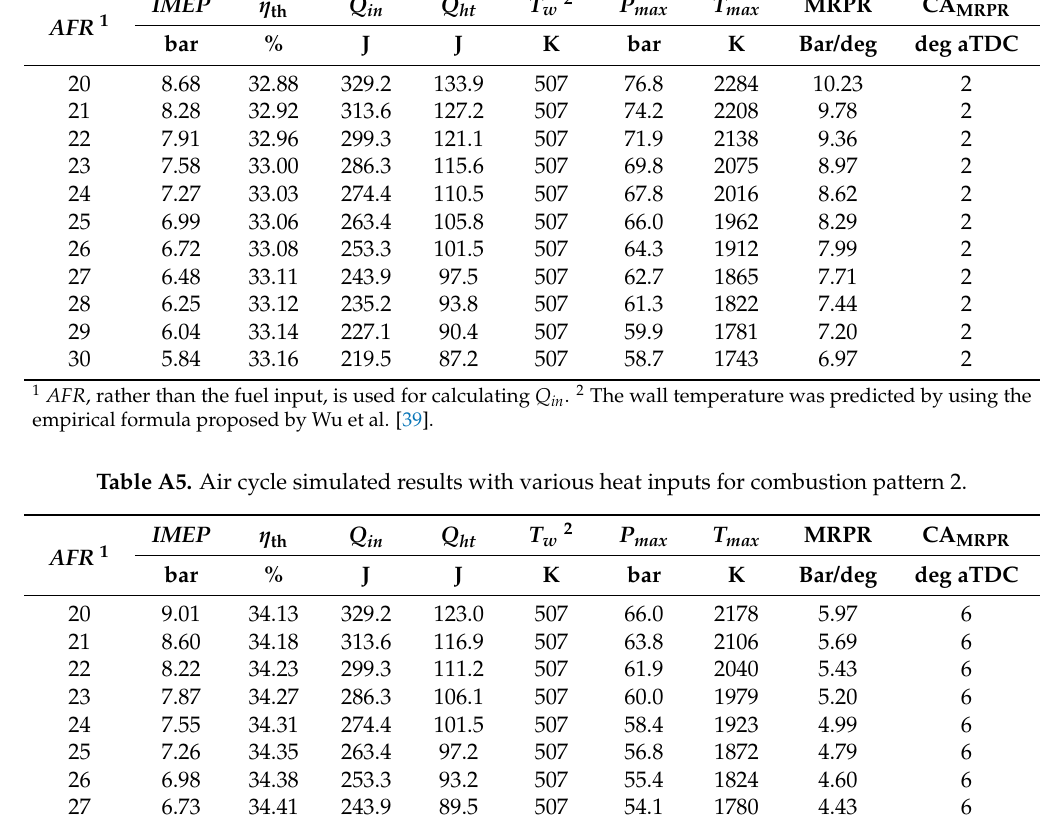
Table A4. Air cycle simulated results with various heat inputs for combustion pattern 1. AFR 1